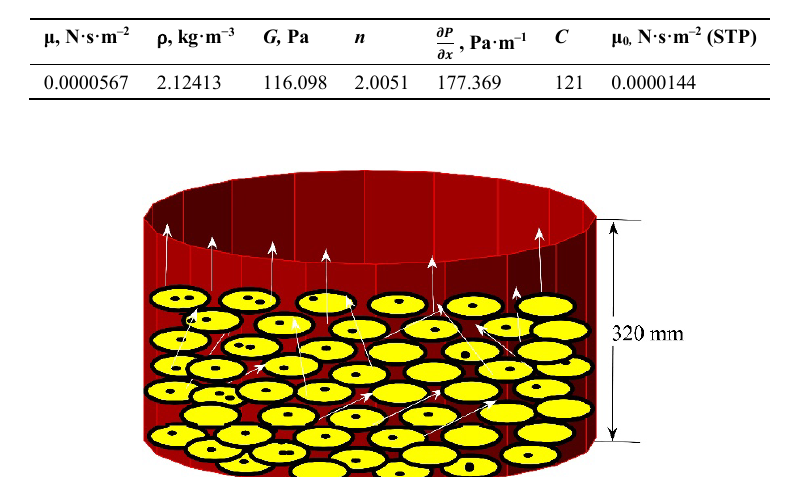
Fig. 3. Graphical illustration of the system.